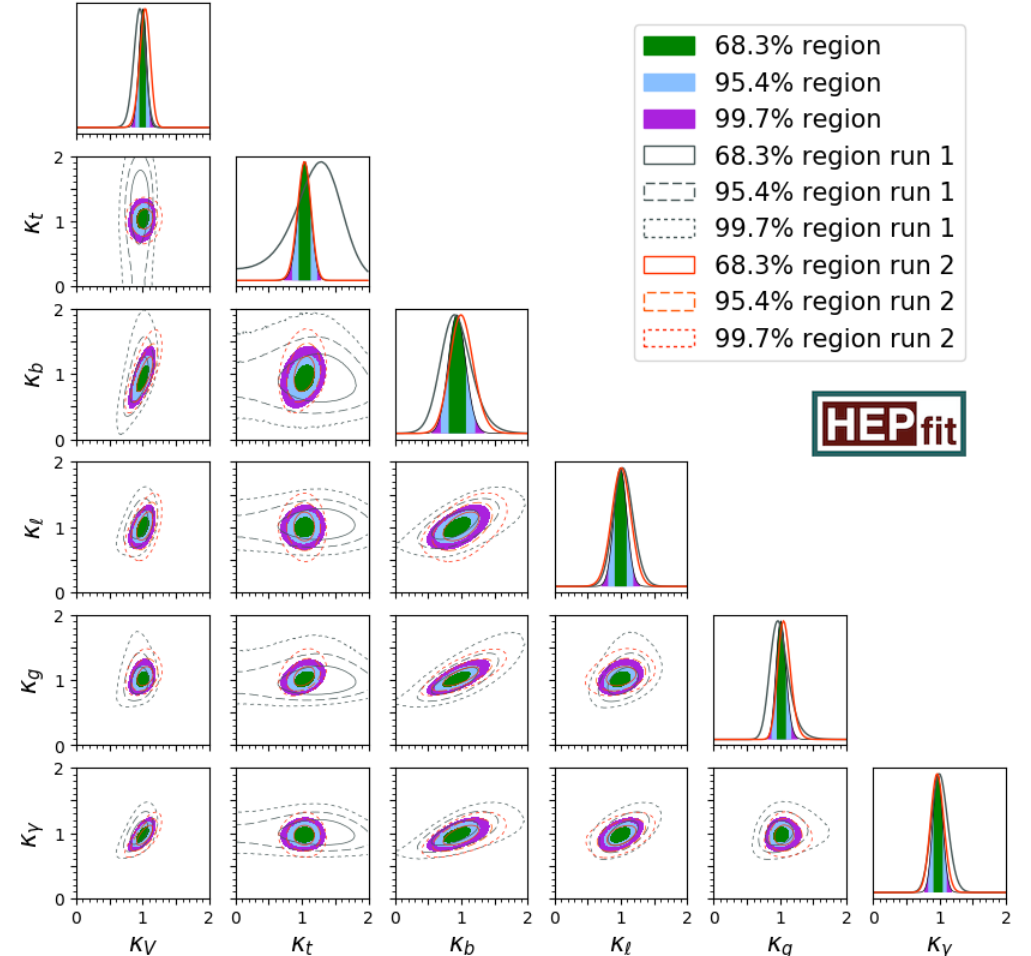
Figure 9 . For the parameters (cid:20) i with i = V; t; b; ‘; g; (cid:13) we display the one-dimensional posterior distribution as well as their two-dimensional correlations. The regions allowed at 68 : 3%, 95 : 4% and 99 : 7% probability by current Higgs data are represented by the green, blue and purple (cid:12)lled contours, respectively. Additionally, we show the single contributions from pre-13 TeV run data (dark gray) and LHC run 2 data